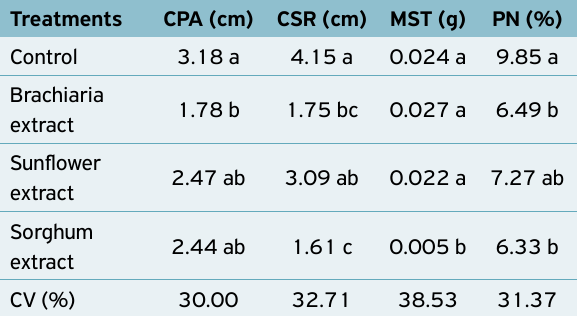
Table 3. Mean shoot, root system length and percentage of normal seedlings of Bidens pilosa L. submitted to treatments with extracts, Cruz das Almas, BA,